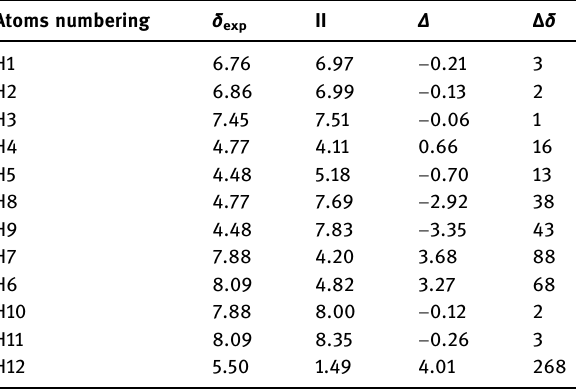
Table 10: Experimental ( δ exp ) and calculated chemical shifts ( II ) for compound 2 Atoms